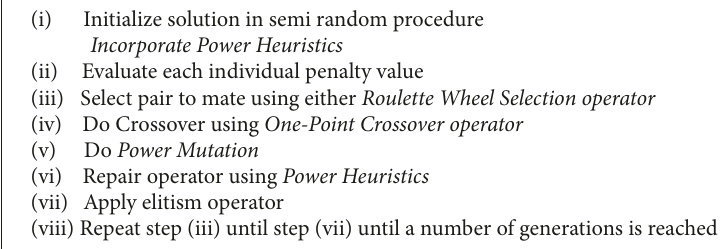
Algorithm 1: The EA algorithm.